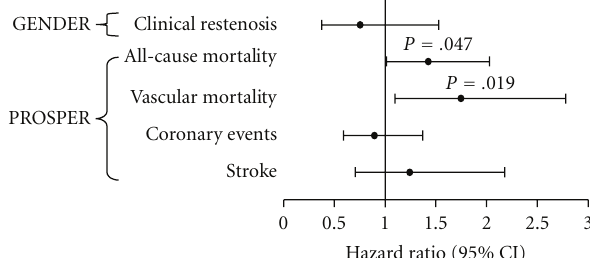
Figure 2: Marburg II hazard ratios for vascular endpoints in GENDER and PROSPER. As the Marburg II polymorphism does not lead to altered enzymatic activity, the similar trends that were observed for this variant are probably a result of the high linkage disequilibrium between the Marburg variants. Despite high confidence intervals, a significant e ff ect was observed on mortality.